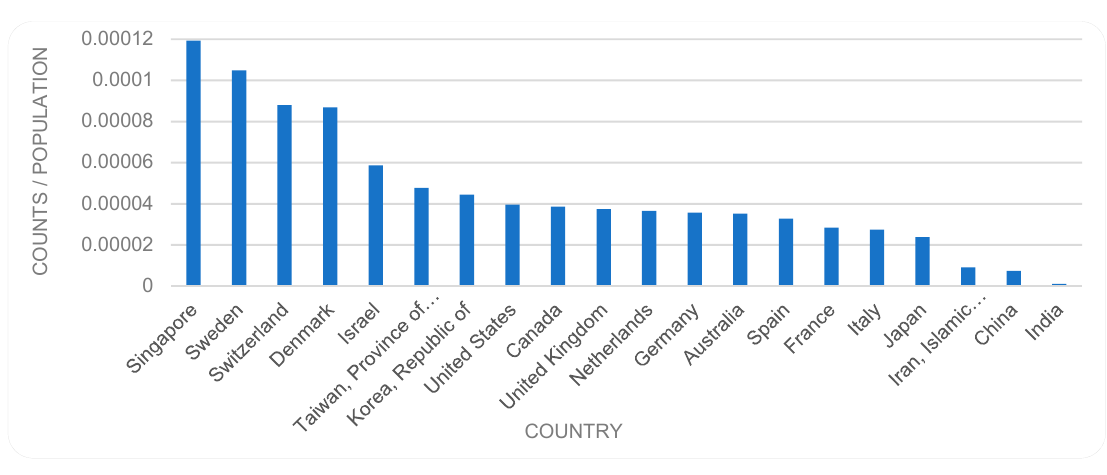
Figure 11. Publication trends per capita.